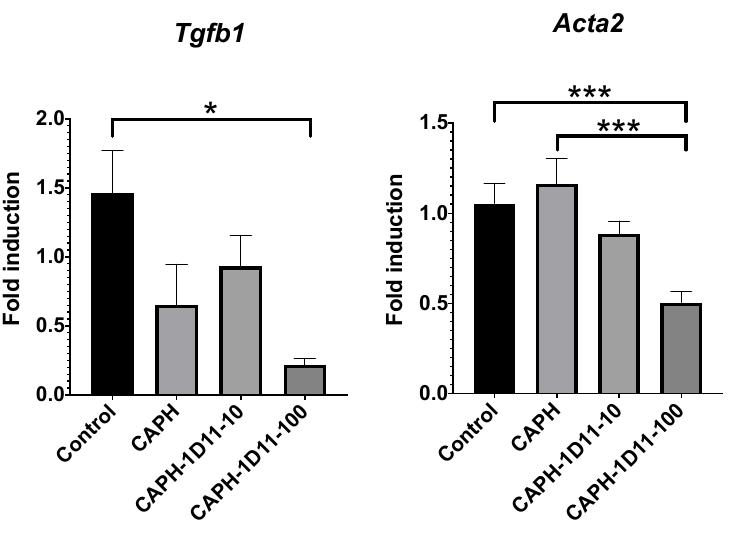
Figure 4. Reverse transcription and real-time PCR of transforming growth factor beta 1 (Tgfb1) and alpha-smooth muscle actin (Acta2) genes in skin lesions. mRNA levels of Tgfb1 and Acta2 genes were measured in skin lesions 10 days after treatment with Ca-alginate-PEGMA hydrogel (CAPH) or CAPH loaded with 10 or 100 μ g 1D11.16.8 antibody (CAPH-1D11-10 and CAPH-1D11-100, respectively). Data were normalized to hypoxanthine phosphoribosyltransferase (HPRT) mRNA and presented as mean of fold induction (n = 5/group) ± SEM. Significance denoted as * p < 0.05 and *** p < 0.001.